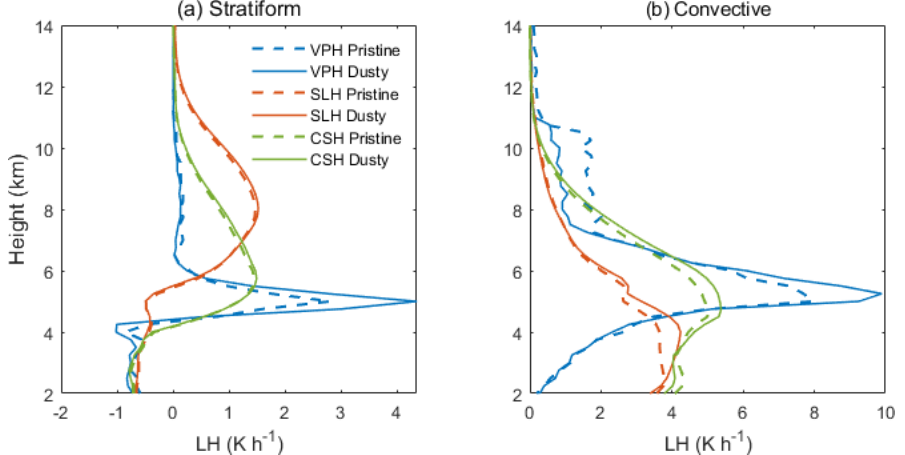
Figure 6. The mean latent heating ( LH ) profiles retrieved using the VPH (blue), SLH (red), and CSH (green) algorithms for (a) stratiform precipitation and (b) convective precipitation under pristine (dashed lines) and dusty (solid lines)